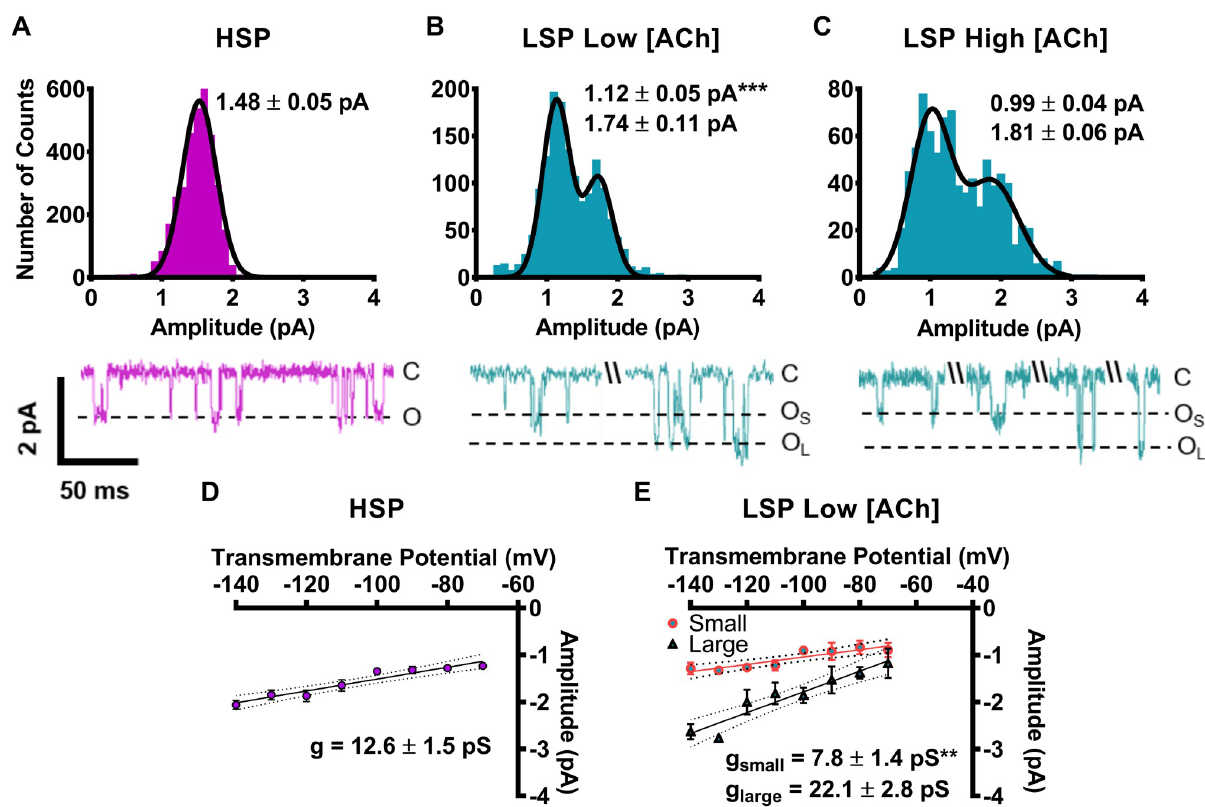
Fig 3. Unitary amplitudes and conductances associated with human HSP ( α 4 β 2) 2 β 2-nAChR and LSP ( α 4 β 2) 2 α 4-nAChR expressed in X . laevis oocytes from pentameric, fully-concatenated constructs (HSP and LSP, respectively). All statistical comparisons for this figure were performed using two-tailed unpaired Student’s t-tests, df = 8–13, significant differences were noted at P < 0.05. (A) HSP ( α 4 β 2) 2 β 2-nAChR (magenta bars) stimulated with 1.3 μ M ACh produced single-channel openings with a single characteristic amplitude which was indistinguishable from that measured in Fig 2A, for the same isoform expressed using unlinked subunits. (B) LSP ( α 4 β 2) 2 α 4-nAChR (cyan bars) single-channel openings were recorded in the presence of a low ACh concentration (0.7 μ M). These openings fell into two amplitude classes (small and large), associated with values indistinguishable from those determined in Fig 2B, for the same isoform expressed using unlinked subunits. (C) LSP ( α 4 β 2) 2 α 4-nAChR were stimulated with a high ACh concentration (30 μ M). Openings displayed two distinct amplitudes, which were statistically indistinguishable from those recorded in panel (B), using a low ACh concentration. Amplitude histograms are all of the events for each construct and ACh concentration from individual single-channel patch recordings. As in Fig 2, example traces are shown below panels (A), (B), and (C), which display a mixture of individual openings and short bursts of activity, interspersed with longer periods of inactivity. (D) Single-channel slope conductance was calculated for openings of HSP ( α 4 β 2) 2 β 2-nAChR by calculating the mean single-channel amplitude across several transmembrane voltages. The value obtained was not statistically different to that recorded from ( α 4 β 2) 2 β 2-nAChR expressed from unlinked subunits. (E) The single-channel slope conductances associated with small and large openings of LSP ( α 4 β 2) 2 α 4-nAChR (g small and g large , respectively) were also determined. The conductance value g small was significantly lower than that associated with openings of the HSP isoform ( � P < 0.05) and significantly lower than that associated with the large openings of the LSP isoform ( �� P < 0.01). Conductances of small and large amplitude events expressed using the concatemer approach did not differ from events produced by the loose subunit technique. Values are given as mean ± S.E.M, and were collected from 5–6 patches across a minimum of three separate experiments. All recordings were performed 3—6d following cRNA injection.